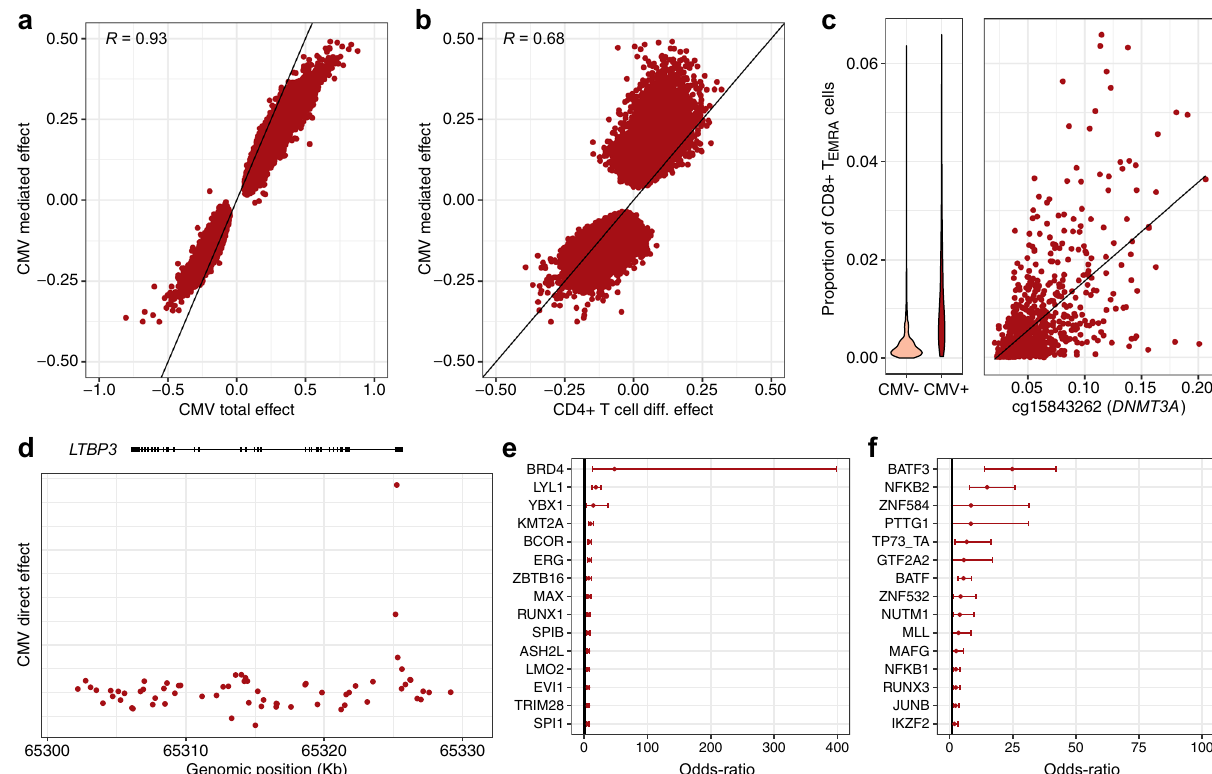
Fig. 2 | Effects of cytomegalovirus infection on the blood DNA methylome. a Totaleffectsagainst cell-composition-mediatedeffects of CMVinfectionon5mC levels. b Effects of CD4 + T cell differentiation on 5mC levels against cell- composition-mediated effects of CMV infection on 5mC levels. c Proportion of CD8 + T EMRA cells in CMV – and CMV + donors (left panel). 5mC levels at the DNMT3A locusagainsttheproportion of CD8 + T EMRA cells (rightpanel). 5mClevels aregiven in the β value scale. The black line indicates the linear regression line. d Genomic distribution of direct effects of CMV infection at the LTBP3 locus. e Enrichment of CpG sites with a signi fi cant direct, positive effect of CMV infection in binding sites